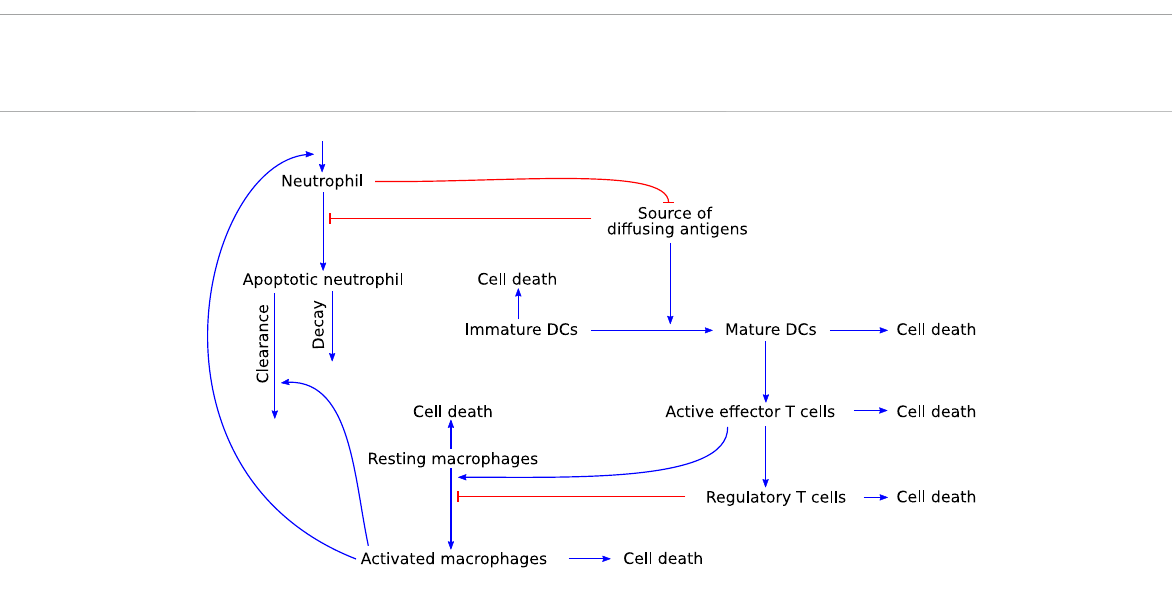
FIGURE 6 Graphical representation of the model developed by Su et al. (2009), which describes an immune response that includes both the innate and adaptive arm of the immune system. Blue arrow-heads indicate stimulation, red bar-heads indicate